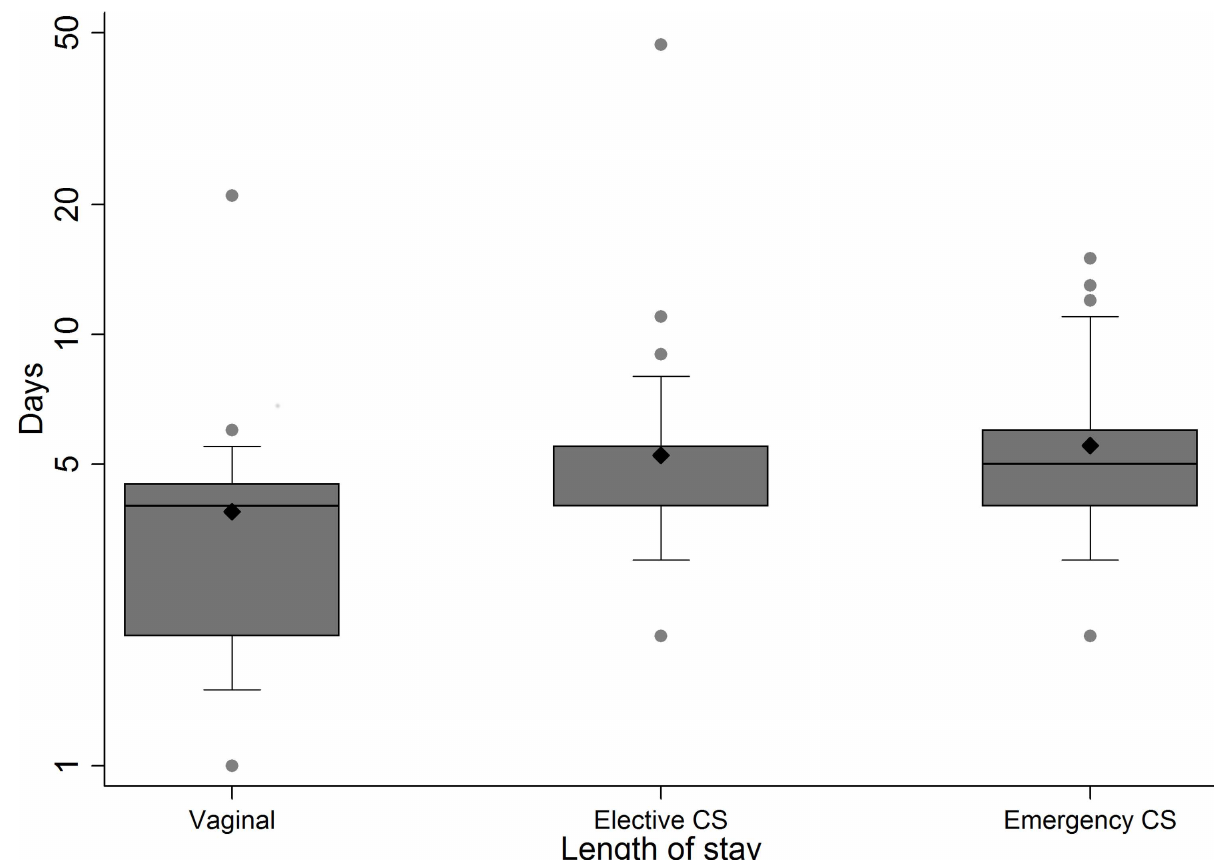
the results did not reach statistical significance (95% CI 1.0–1.9). However, extremely preterm infants were twice as likely to receive antibiotics compared to term infants (RR 2.4, 95% CI 1.5–3.7) and there was a significant dose-response relationship for “term”, “moderately pre- term”, and “extremely preterm” infants in relation to antibiotic treatment (p < 0.01). There was no statistically significant association between antibiotic treatment and sex or age among term